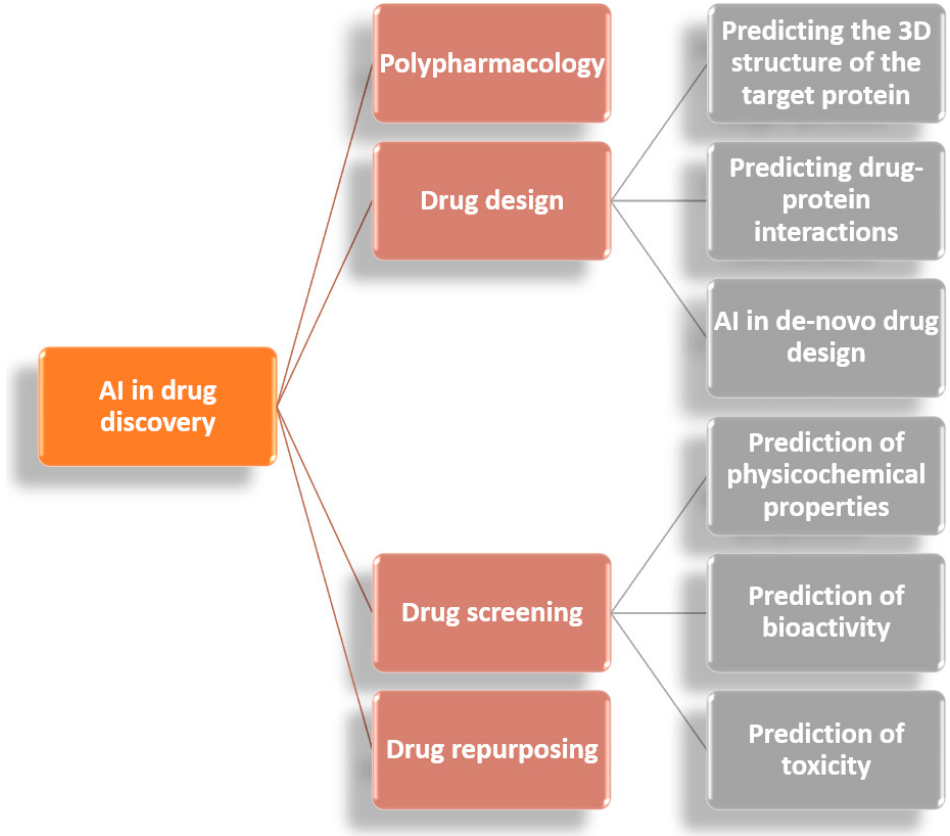
Figure 4. Applications of AI in drug discovery. Adapted from [14].